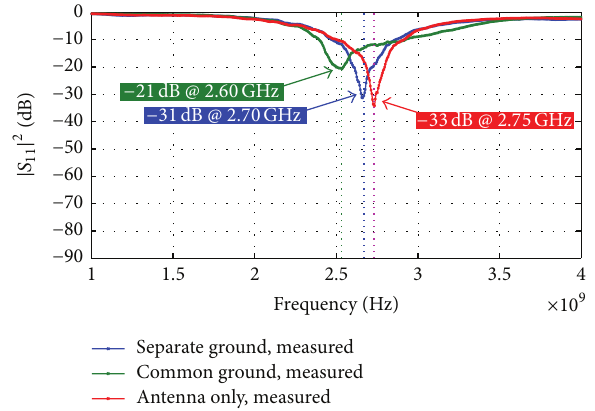
Figure 8: Power of the antenna with and without board